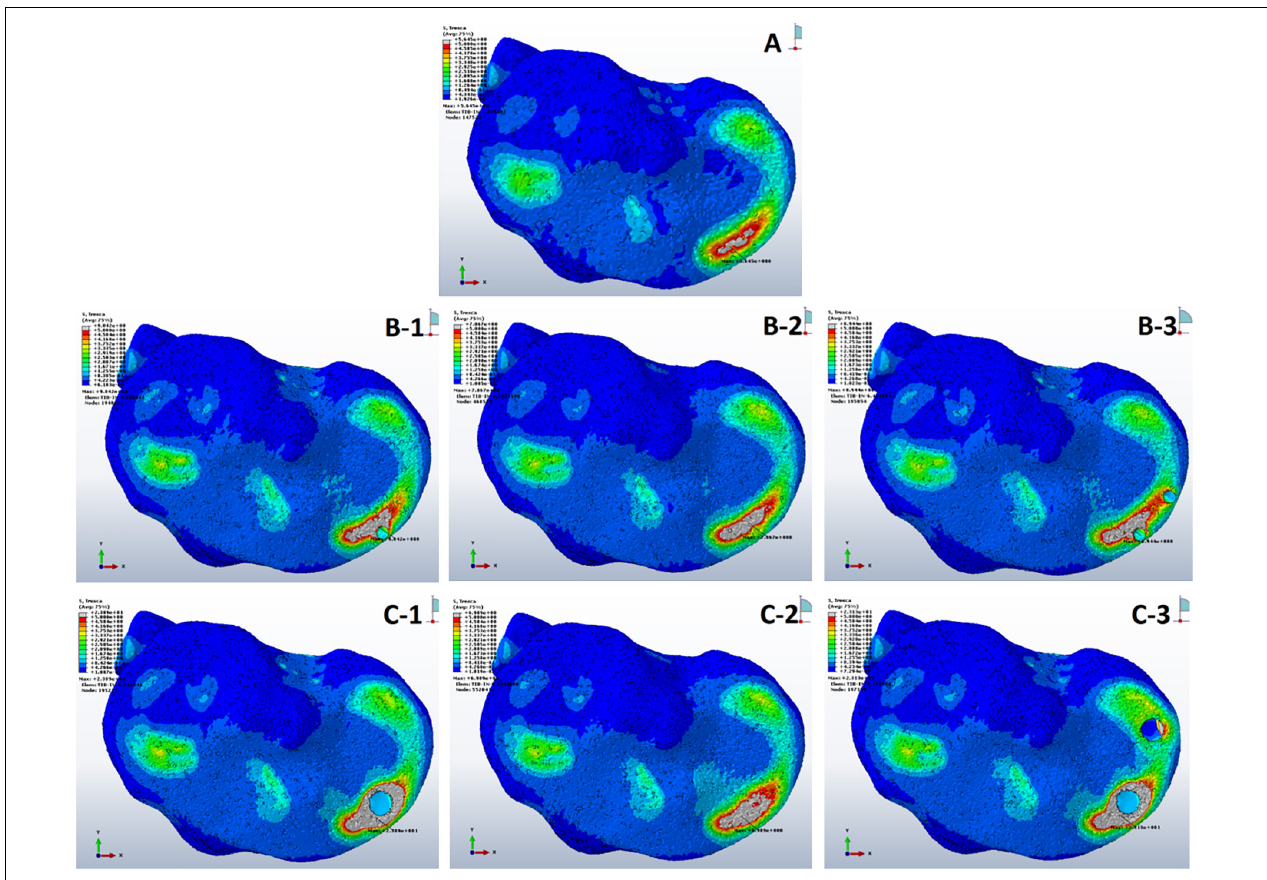
FIGURE 4 | Stress distribution in peri-cystic cancellous bones. (A) Non-cystic knee model. Groups B and C (represented by letters B,C ) with corresponding sub-groups1, 2 and 3.